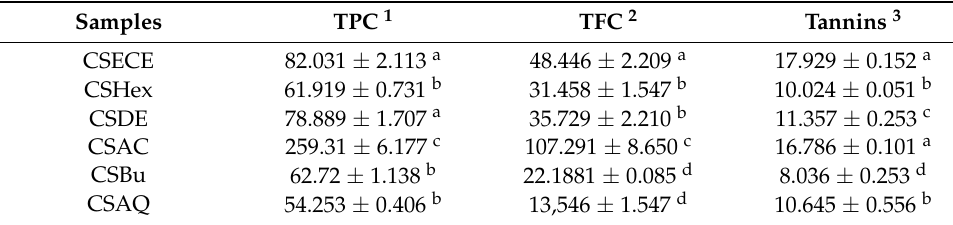
Table 2. Results of the determination of phenolic